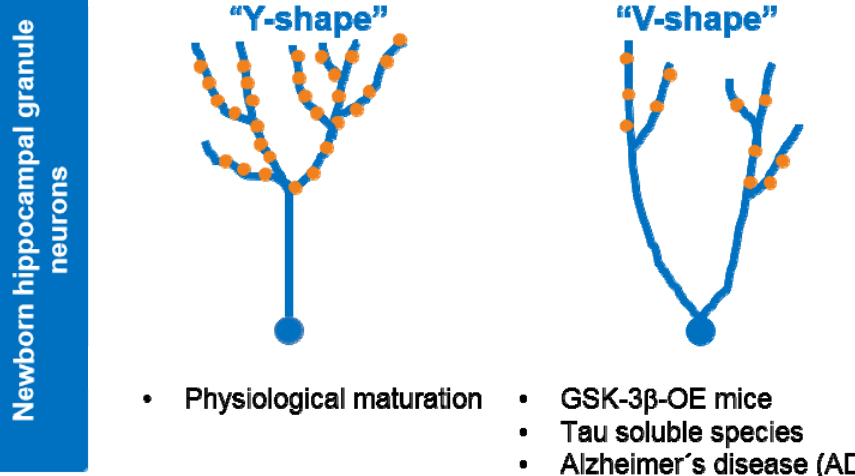
Figure 3. Alterations to dendritic tree morphology and postsynaptic densities in newborn granule neurons upon GSK-3 β overexpression or exposure to soluble tau. Under physiological situations (control), maturation of newborn granule hippocampal neurons leads to a dendritic tree with a “Y-shape” that presents a single apical primary dendrite and several distal branches. Upon GSK-3 β overexpression (OE) or soluble tau exposure, cells acquire a “V-shape”, with numerous apical dendrites and atrophied distal branching, and show a marked depletion of postsynaptic densities ( • PSDs). Neurons from AD patients show similar morphological alterations. At least part of the observed effects of GSK-3 β in AHN might be mediated by tau